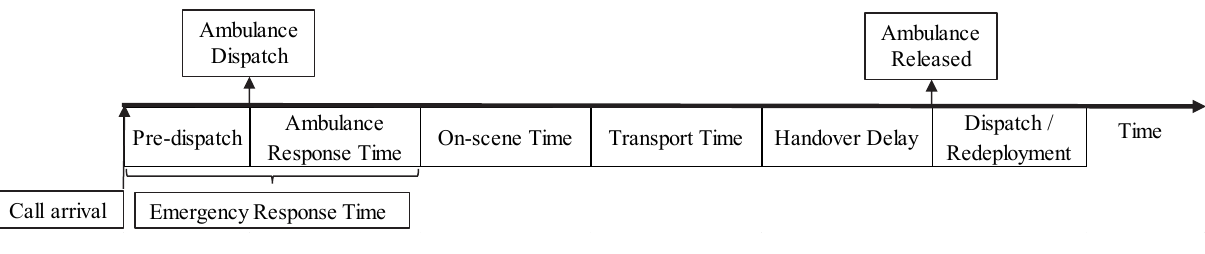
Fig. 1. Operation time of an